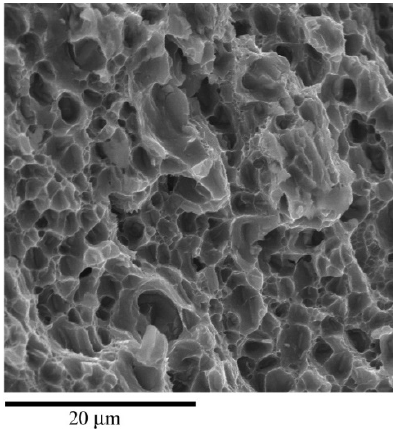
Figure 7. The fracture surface of the V95 alloy after specimen tension at room temperature.